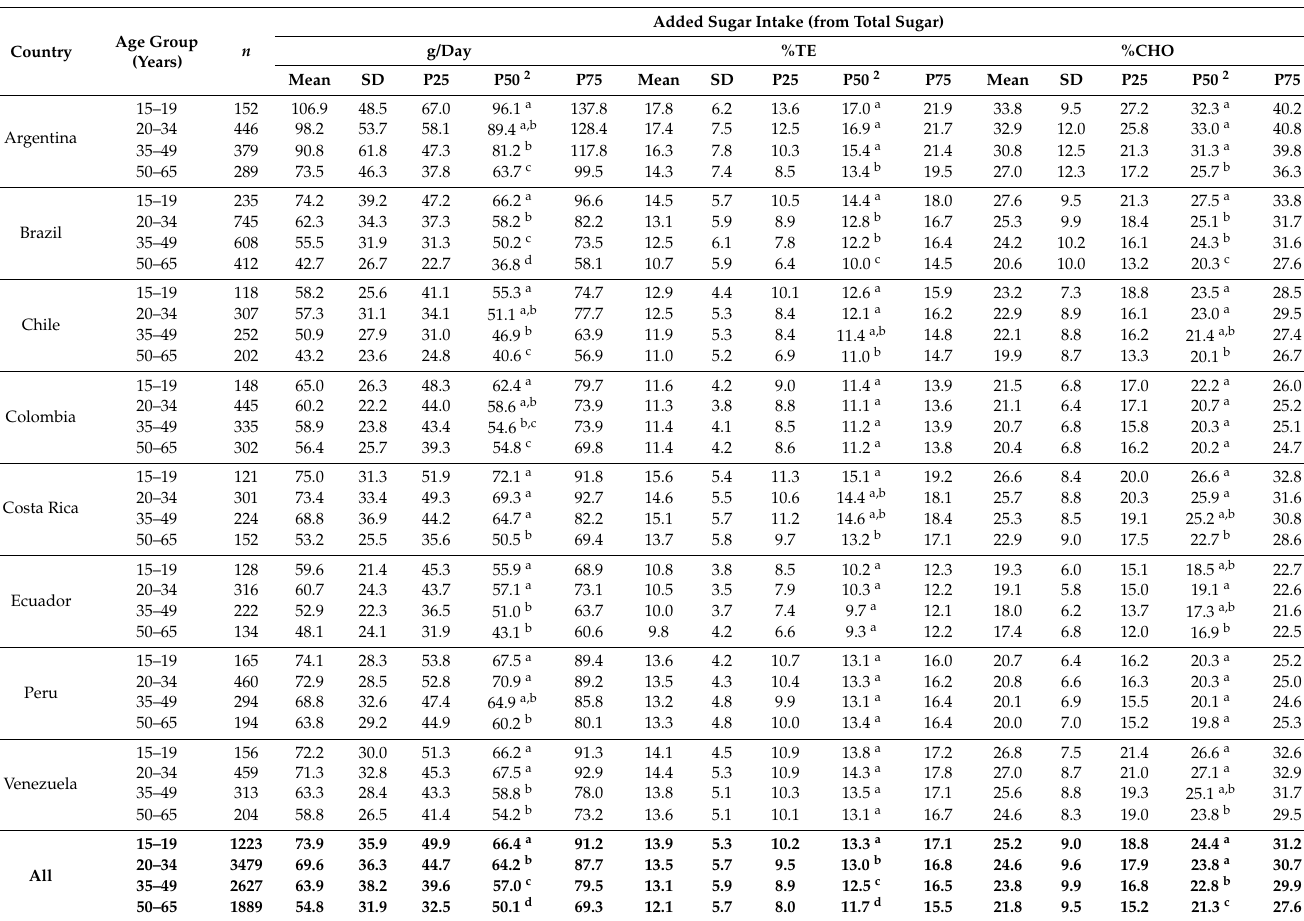
Table 8. Added sugar intakes 1 in individuals residing in urban areas of Latin American countries, according to age groups; Latin American Health and Nutrition Study (ELANS),